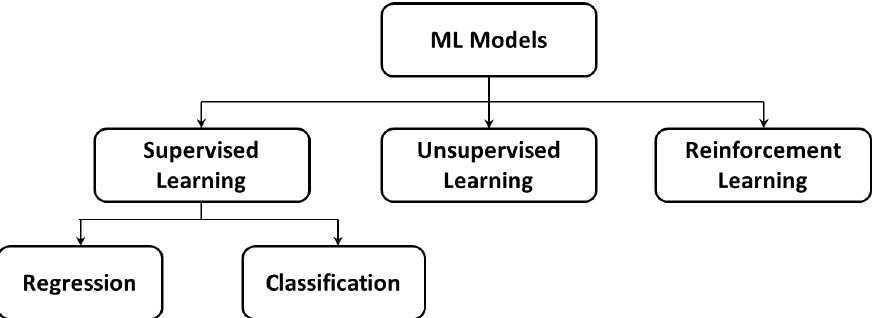
Figure 2. The basic classification scheme for different types of machine-learning. Table 1. A non-exhaustive list of machine-learning models and approaches that are categorized according to basic types of machine-learning.